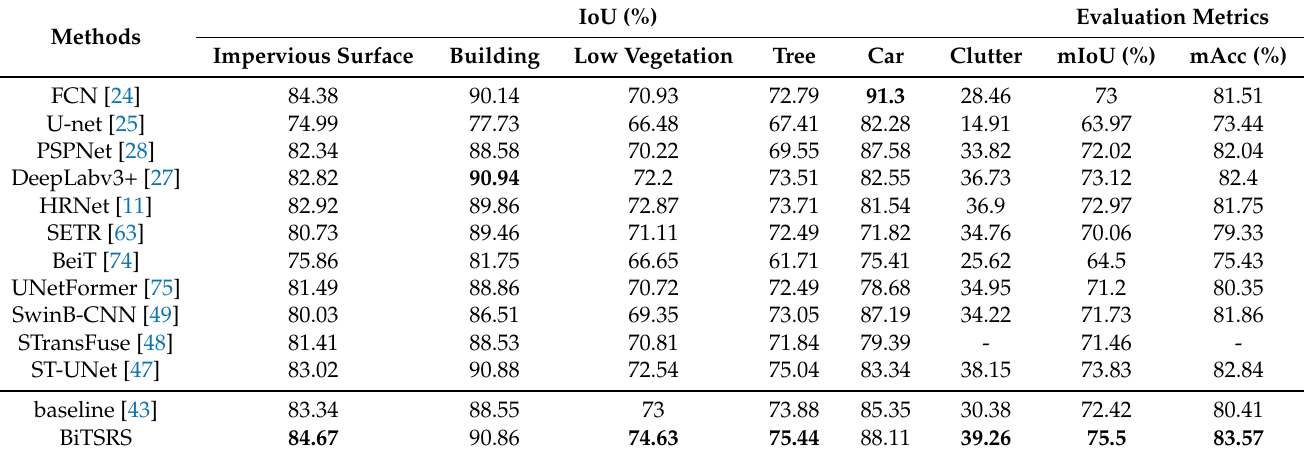
Table 5. Comparison with some state-of-the-art methods on the ISPRS Potsdam dataset. The maximum value of each column is shown in